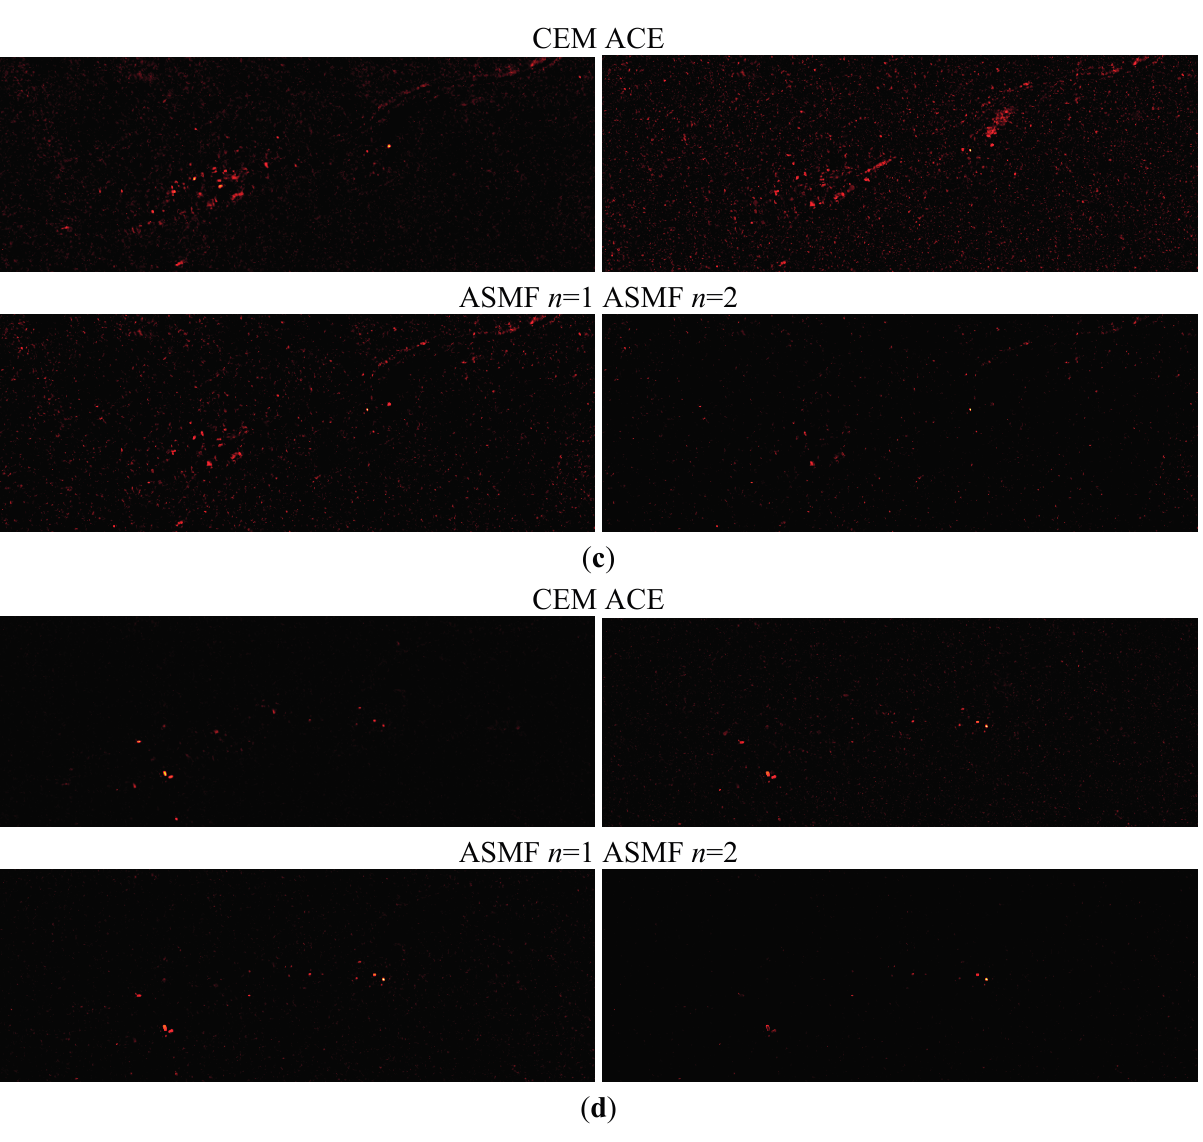
Figure 17. 2-D plots of the detection results using the whole HyMap dataset by all the comparison algorithms of ( a ) F1, ( b ) F2, ( c ) F3, and ( d ) F4.